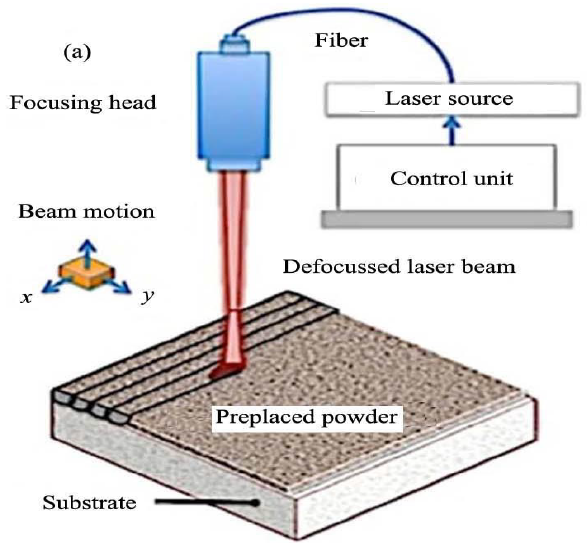
Figure 1: The schematic diagram of laser cladding with preset pow- der method [7]